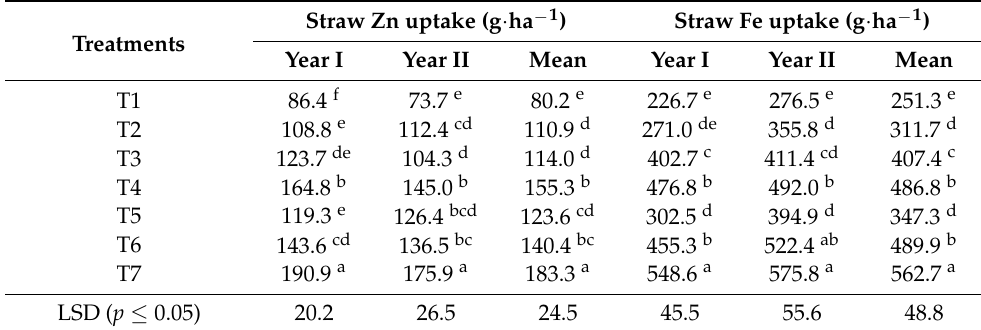
Table 6. Effect of biofortification on Zn and Fe uptake in straw of lentil.